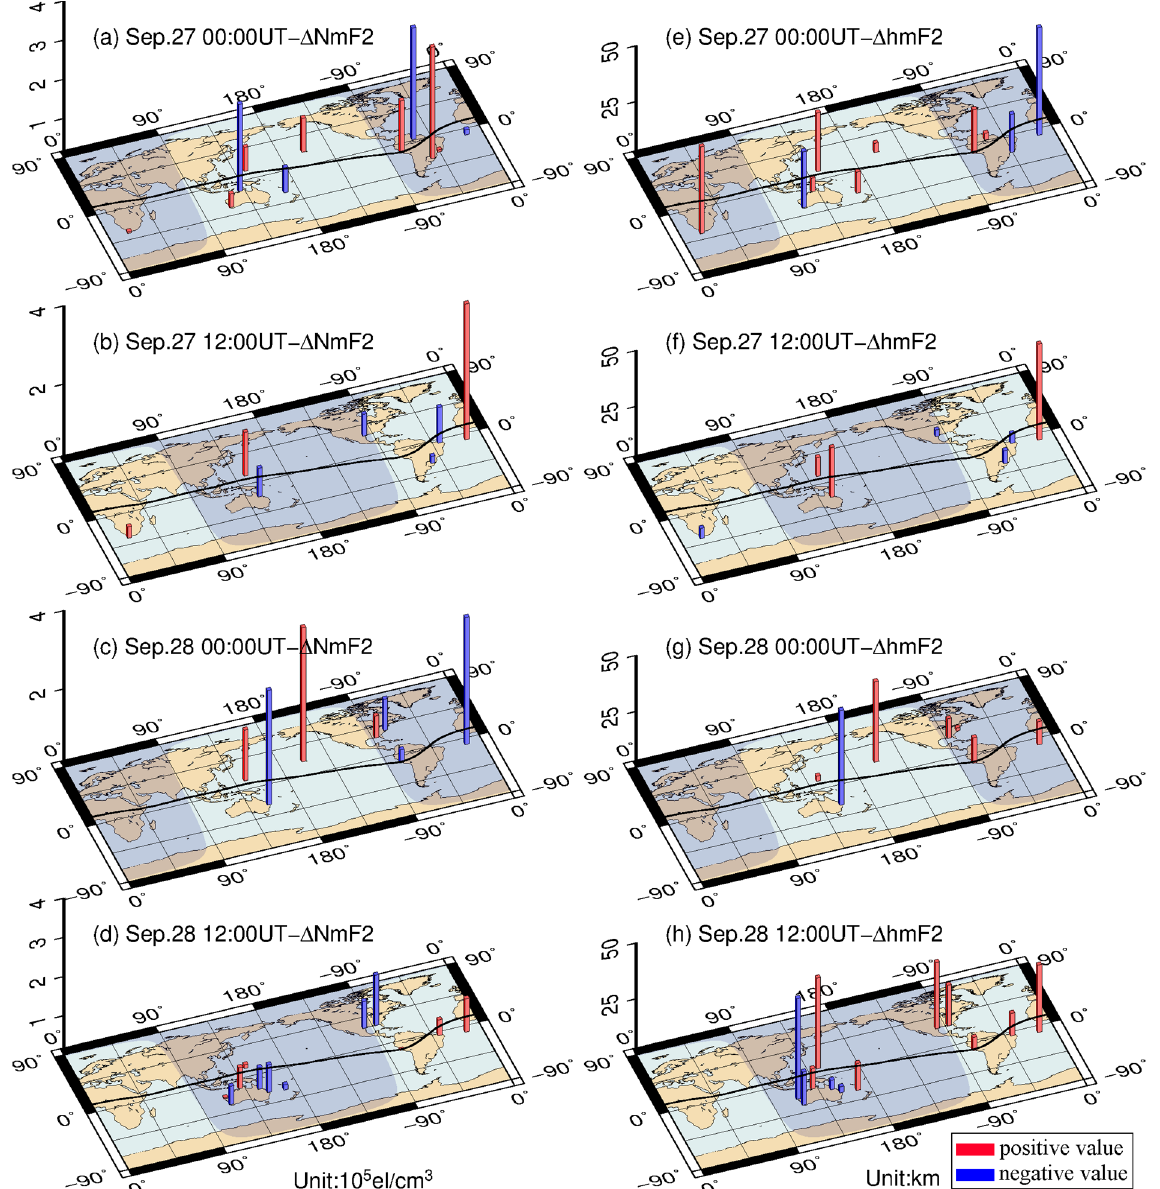
Figure 10. Snapshots for the absolute errors in NmF2 ( left column ) and hmF2 ( right column ) obtained from COSMIC-2 observations in comparison with the reference of ionosonde results during September 27–28, 2020. In each subfigure, the black line represents the geomagnetic equator; the edge of the shadow area is the terminator line; the red and blue bars represent positive and negative values, respectively.